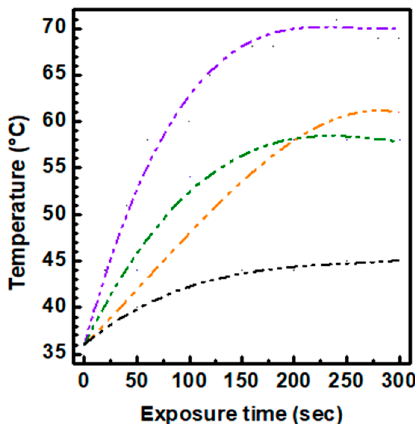
Figure 4. Photothermal kinetics of CDs 8bar (green line), CDs 13bar (orange line) and CDs 18.5bar (purple line) compared with ultrapure water treated under the same conditions (black line). Samples (0.1 mg mL − 1 ) were excited with an 810 nm diode laser source with power of 5 W cm − 2 .